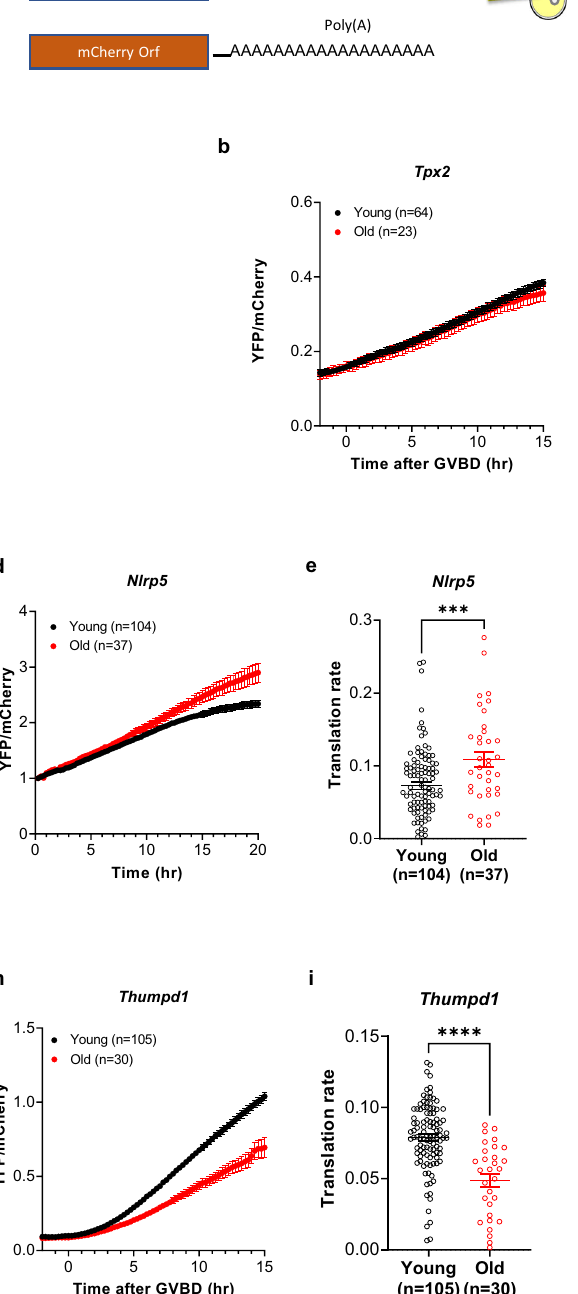
Fig. 2 | Complex alterations in translation are detected in old oocytes com- paredtoyoungoocytes.a SchemeofYFPreporterassay.GVoocytesfromyoung and old mice were injected with 12.5ng/ μ l polyadenylated mCherry and 12.5ng/ μ l of oligoadenylated YFP reporters, including Tpx2, Nlrp5, Il7, Thumpd1, and Golph3 3 ’ -UTR. After overnight pre-incubation, oocytes were released in cilostamide-free medium, and YFP and mCherry signals were recorded by time-lapse microscopy every 15min for 20h during maturation. The YFP signals were normalized by the levelofmCherrysignals. b , d , f , h , j TheratioofYFP/mCherrysignalforeachoocyte wasplottedaccordingtotheincubationtime( d )orwithtimeofGVBDsetas0time